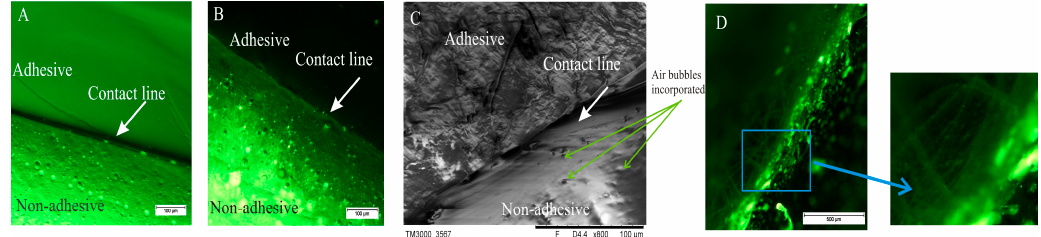
Figure 2. Images from a fluorescence microscope ( A , B , D ) and from an SEM ( C ) of DLASil ( A , C ); DLASil with silicone oil (SO) ( B ); and Cica-Care ( D ).